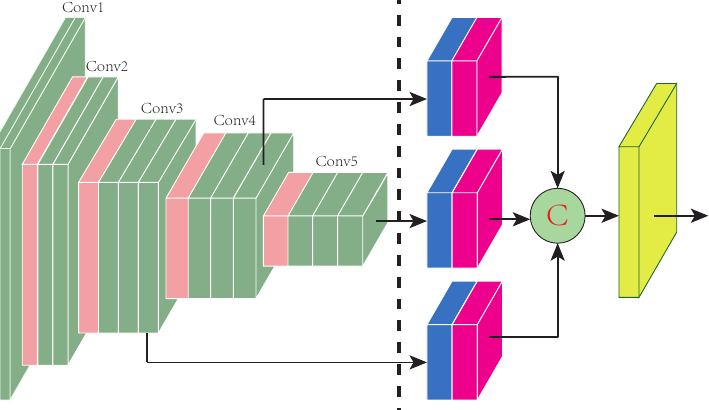
Figure 1. Overview of the proposed deep regression network. The left-side blocks are the fixed-feature extractor backbone. The right-side blocks are trained in the first frame and updated frame by frame. The blue blocks represent the 1 × 1 channel reduction layers, and red blocks represent the normalization and rescale layers. The yellow block indicates the target-specified one-channel-output convolutional regression layer. The connection circle means hierarchy concatenation. The proposed network effectively exploits semantic abstraction across three convolutional